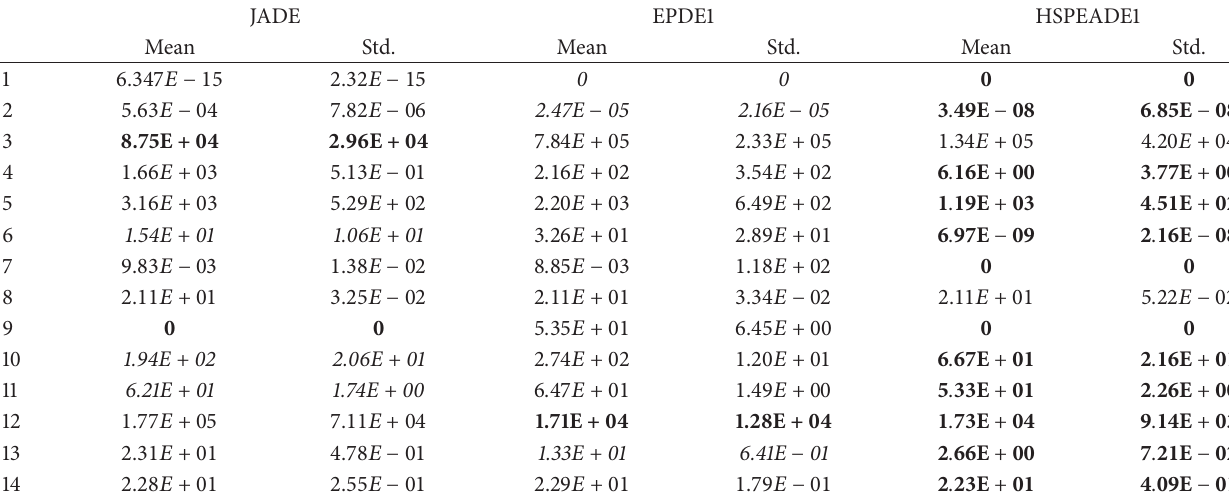
HSPEADE1: “DE/current-to- p best” strategy, bino- mial crossover, 𝐹 , 𝐶𝑅 and 𝑝 are encoded into the HS algorithm for adaptation. 𝐹 ranges from 0.2 to 1.2, 𝐶𝑅 ranges from 0 to 1, and 𝑝 ranges from 0.05 to